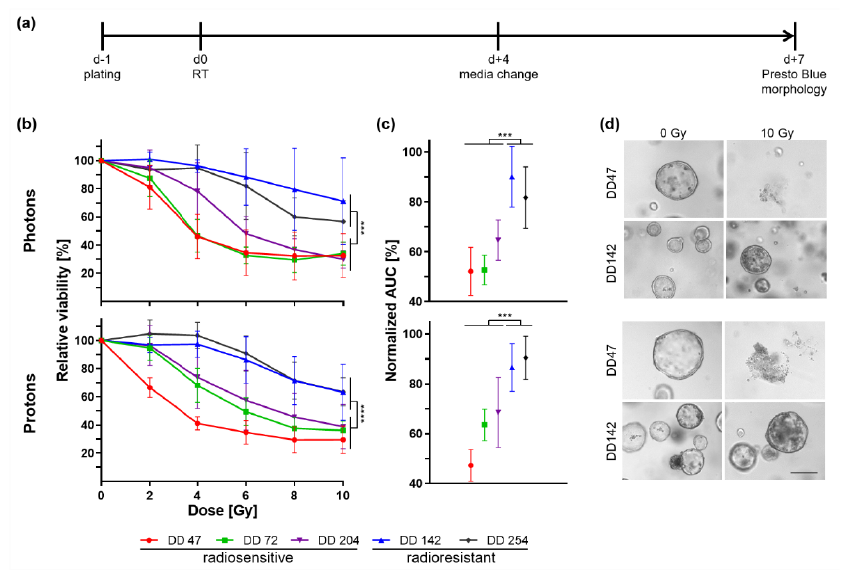
Figure 2. Photon and proton irradiation of CRC PDOs. ( a ) Timeline of experiments. ( b ) Relative viability of irradiated PDOs 7 d post-treatment was measured by a metabolic assay ( p photon ≤ 0.0006, p proton < 0.0001), and ( c ) normalized area under the curve (AUC) was calculated ( p ≤ 0.0005). ( d ) Representative pictures are shown of organoid morphology upon control (0 Gy) and 10 Gy irradiation of a radiosensitive (DD47) and a radioresistant (DD142) line (scale bar: 200 µM; see also Figure S4). ***: p ≤ 0.001, **** : p ≤ 0.0001 .